Question: Is the quantity shown trending increasing or decreasing?
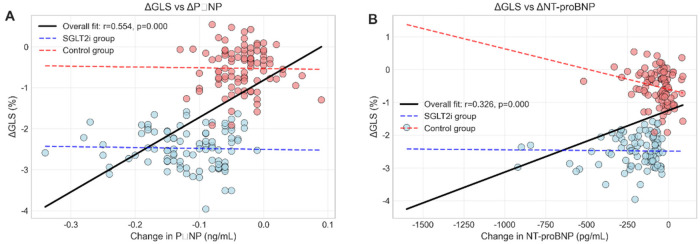
Answer: increasing